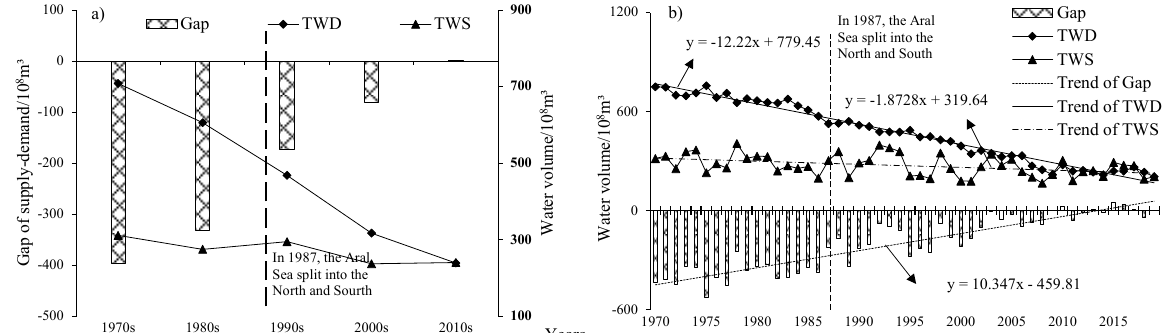
Figure 11. Variations of water supply-demand gap in the study area during 1970 to 2019. Notes: ( a ) Gaps of decade; ( b ) Gaps of years.